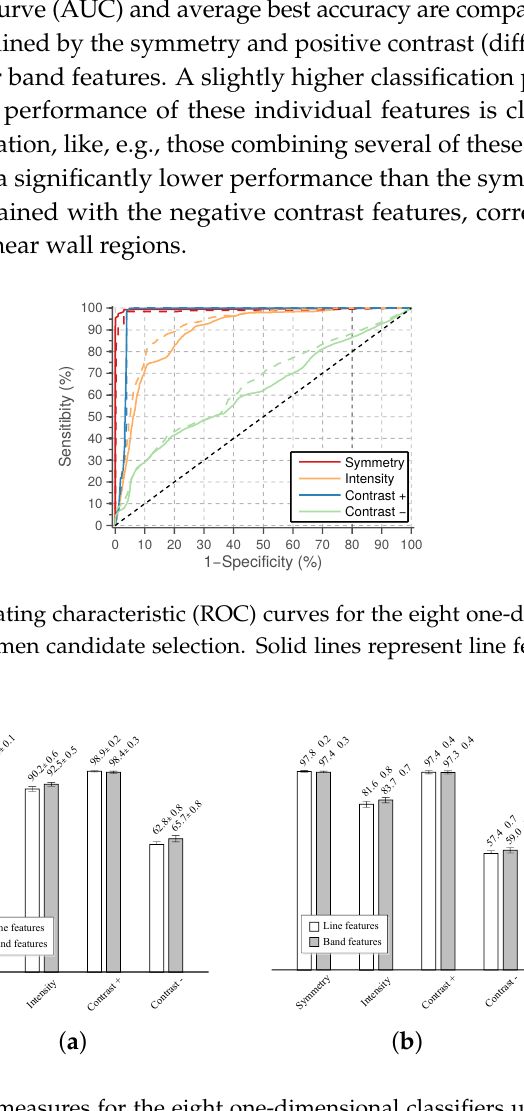
Figure 11. Performance measures for the eight one-dimensional classifiers used for feature-based candidate lumen selection. ( a ) Average area under the curve (AUC); ( b ) average best